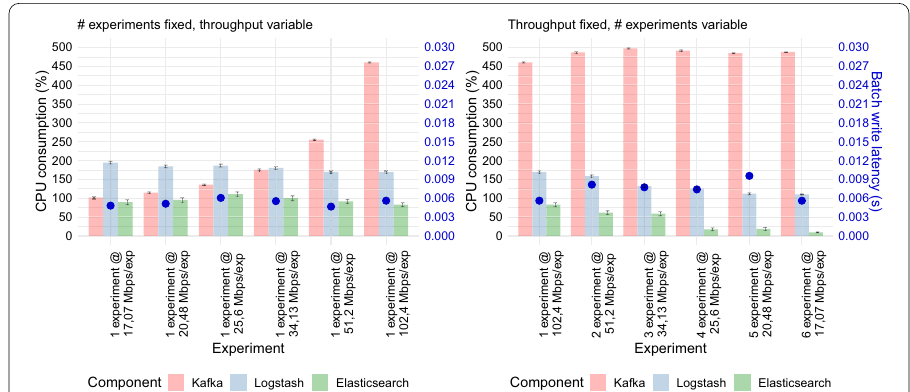
Fig. 6 CPU consumption and batch write latency evolution for 100 B data traffic in different experiments